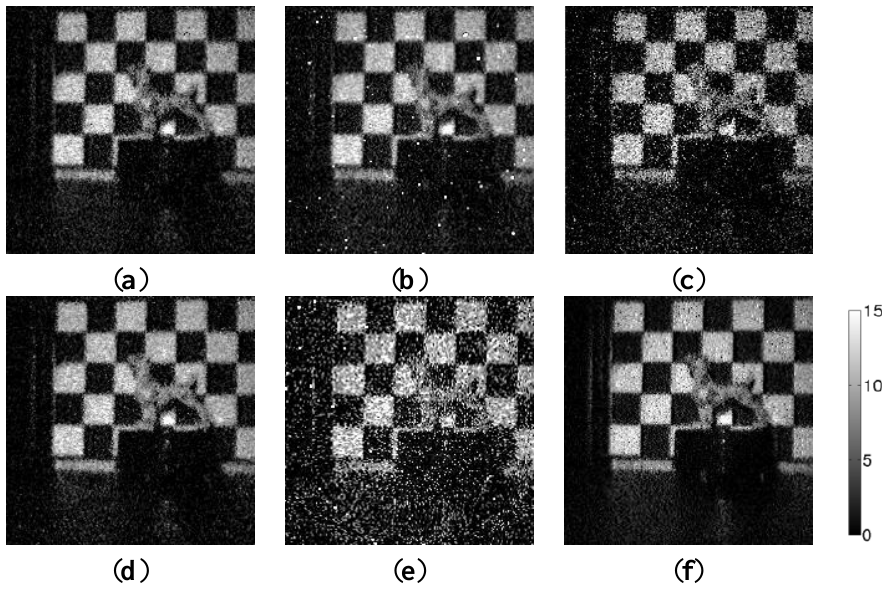
Figure 10. Reproduced images and reference image. ( a ) Selective averaging. ( b ) Simple